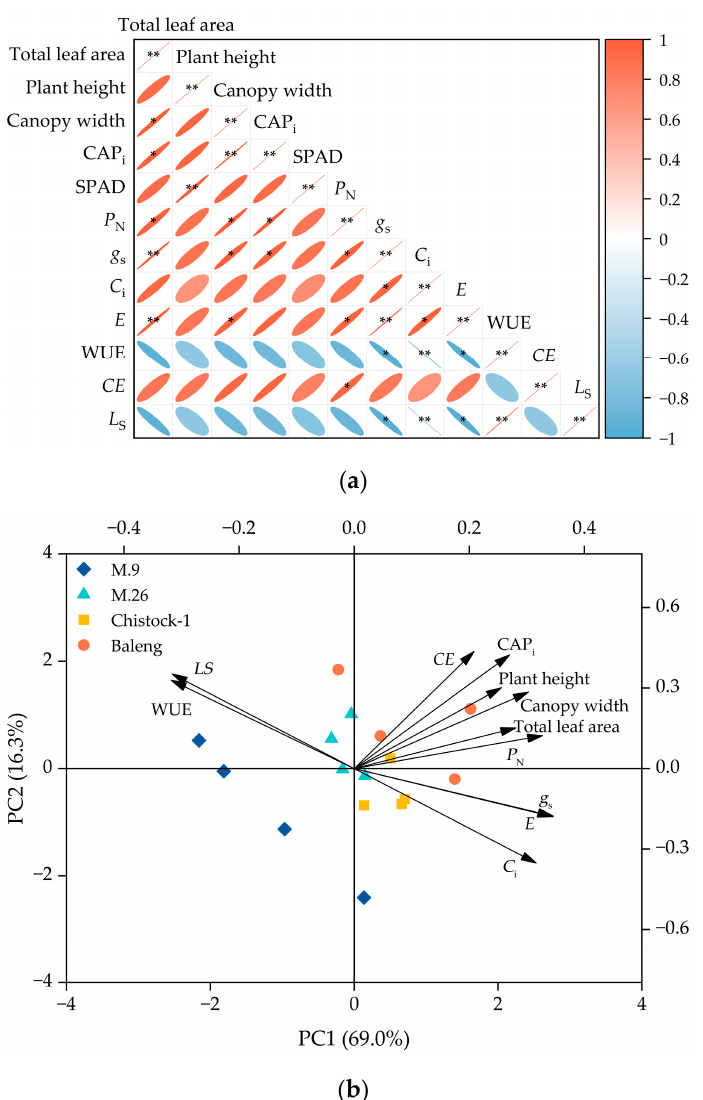
Figure 8. Correlation analysis and principal component analysis (PCA) on the photosynthetic characterization of grafted apple combinations. Correlation heat map involving total leaf area, plant height, canopy width, instantaneous canopy apparent photosynthesis (CAP i ), SPAD, leaf net photosynthetic rate ( P N ), stomatal conductance ( g s ), intracellular CO 2 concentration ( C i ), transpiration rate ( E ), water-use efficiency (WUE), leaf carboxylation efficiency ( CE ), and stomatal threshold ( LS ) ( a ); PCA-based biplot, involving P N , LS , g s , C i , E , WUE, CE , CAP i ; total leaf area; canopy width and plant height ( b ). The ellipses eccentricity in ( a ) denotes Pearson’s correlation among various parameters (at least three replications), and the ‘*’ and ‘**’ indicate significance level ( p < 0.05 and p < 0.01). The upward slope ellipses in red showed positive correlations, and the downward ones in blue indicated negative correlations. The different symbols in ( b ) represent different apple-grafted combinations (at least four replications) and the arrows reflect the vectors of loadings.